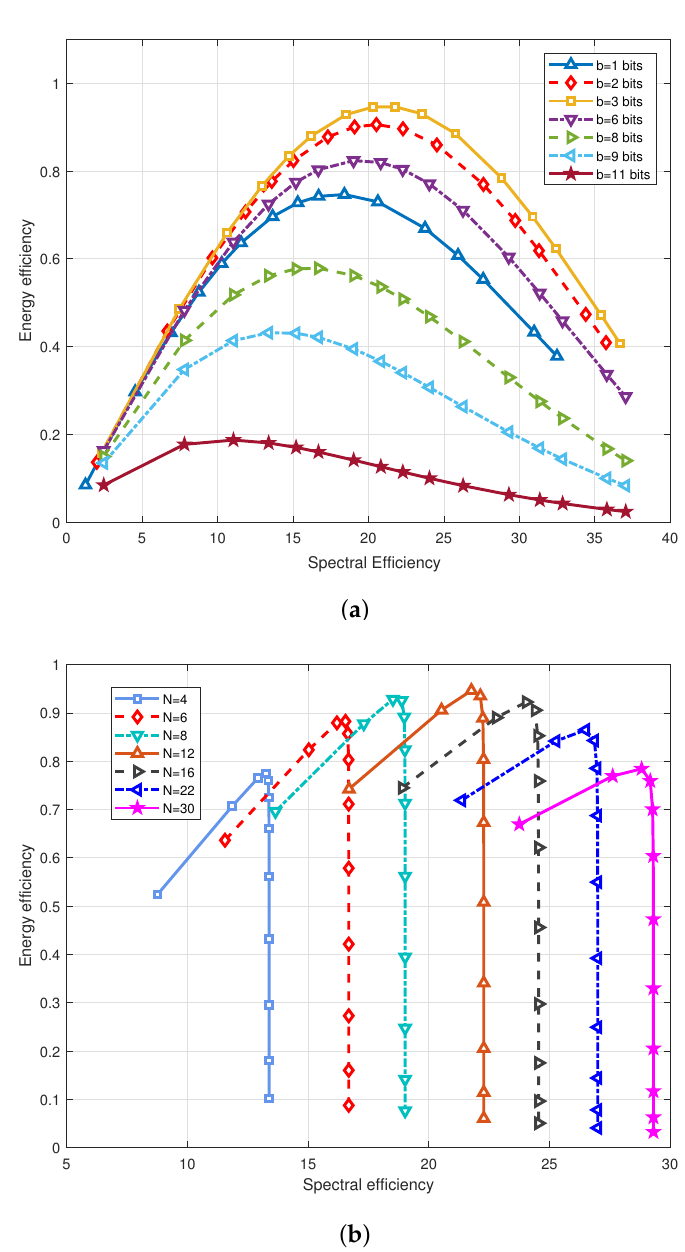
Figure 3. Energy efficiency versus spectral efficiency with different numbers of quantization bits b and different numbers of antennas N per RAU. ( a ) Each line corresponds to different numbers of quantization bits with b = [1, 2, 3, 6, 8, 9, 11] and the points on each line correspond to different numbers of antennas per RAU with N = [1:1:6, 8, 10, 12, 15, 20, 30, 40, 50, 80, 100]. ( b ) Each line corresponds to different numbers of antennas per RAU with N = [4, 6, 8, 12, 16, 22, 30] and the points on each line correspond to different numbers of quantization bits with b =